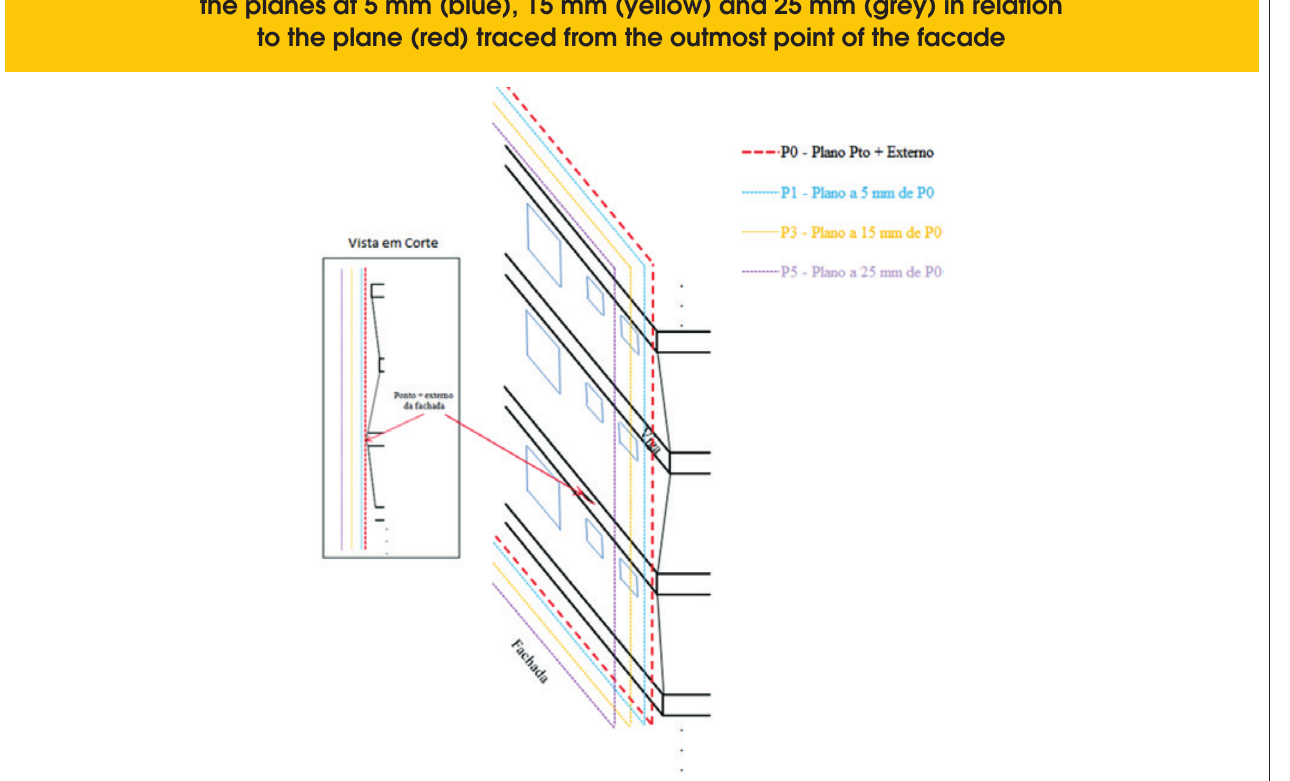
Figure 10 – (a) Detail of the outmost point of the facade in Plane 0'; (b) Illustration of the planes at 5 mm (blue), 15 mm (yellow) and 25 mm (grey) in relation to the plane (red) traced from the outmost point of the